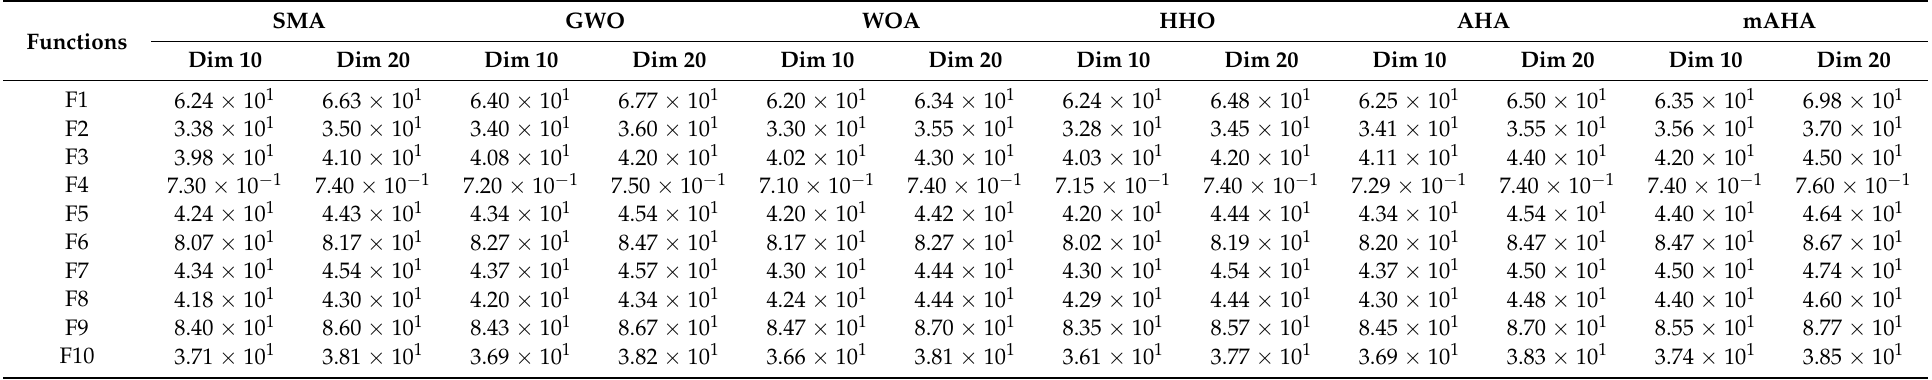
Table 3. The CPU time that has been obtained by the proposed mAHA and the competitor algorithms for 30 runs with Dim 10 and Dim 20 on the CEC’20 test